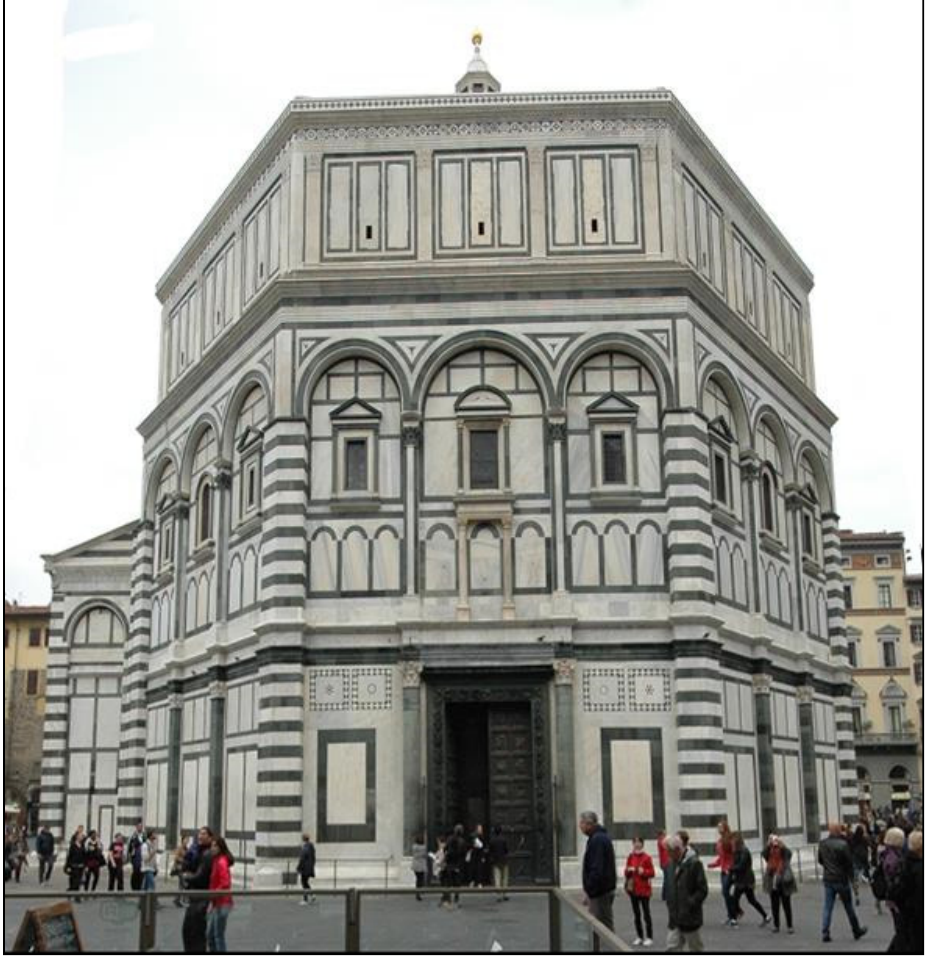
Figure 1. Saint John Baptistery in Florence (Italy), south façade cladded in white and dark marble according to the Tuscan Dichromic.